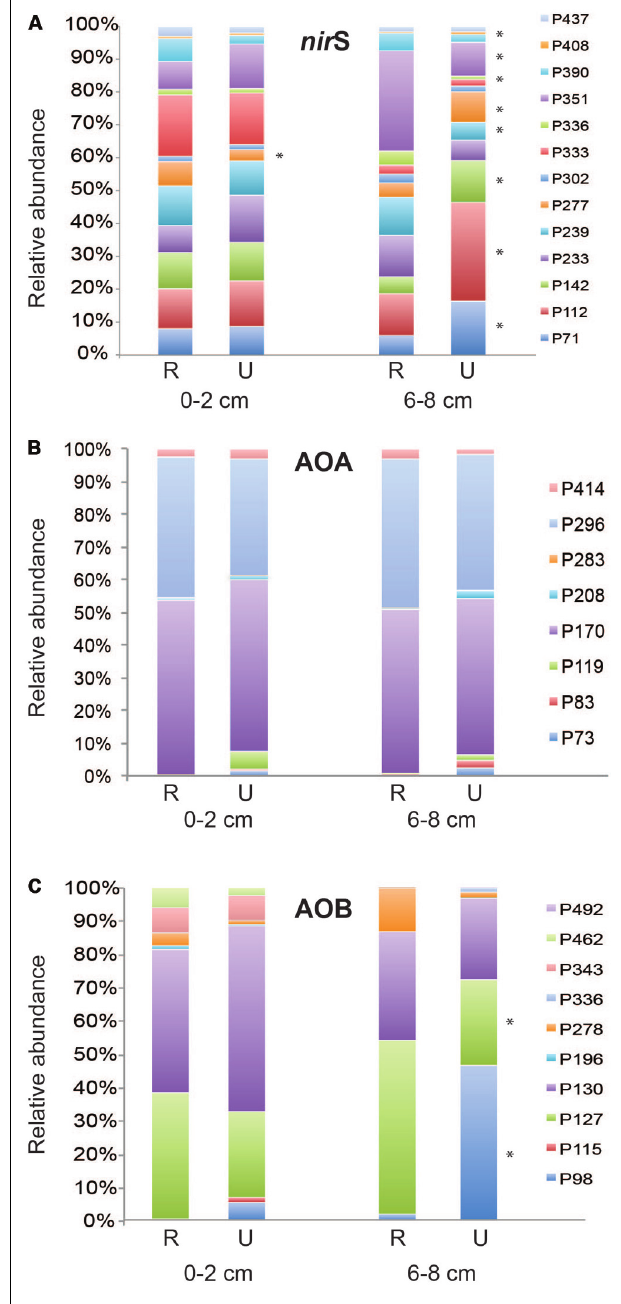
FIGURE 5 | Mean relative abundance of individualTRFs from surface and deep sediments for nir S (A), archaeal amo A (B), and betaproteo bacterial amo A (C) genes. Asterisks next toTRF bars indicate significantly different values ( P ≤ 0.05) of thatTRF between restored (R) and undisturbed (U)